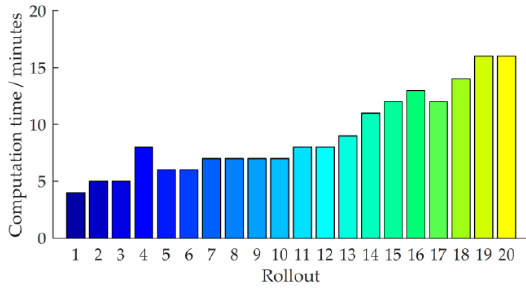
Figure 22. Computational time for each rollout.